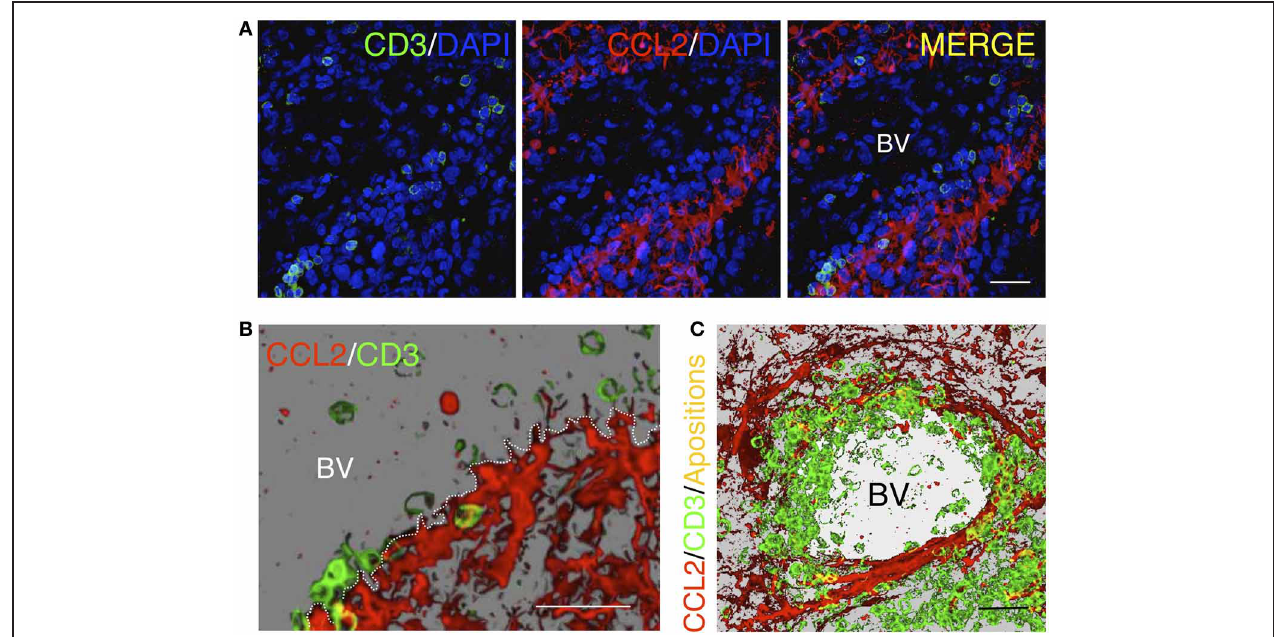
FIGURE 4 | Homing of T-cells in a tumorigenicarea in the human brain. (A) Confocal images of immunofluorescence for CD3 + T-cells (green) and the chemokine CCL2 (red). Cell nuclei are counterstained with DAPI (blue). CCL2 + astrocytes delimit the outer perivascular area of the BV, whereas T-cells are localized near CCL2 + perivascular astrocytes. (B) Three dimensional reconstruction of a detailed region obtained from the confocal images shown